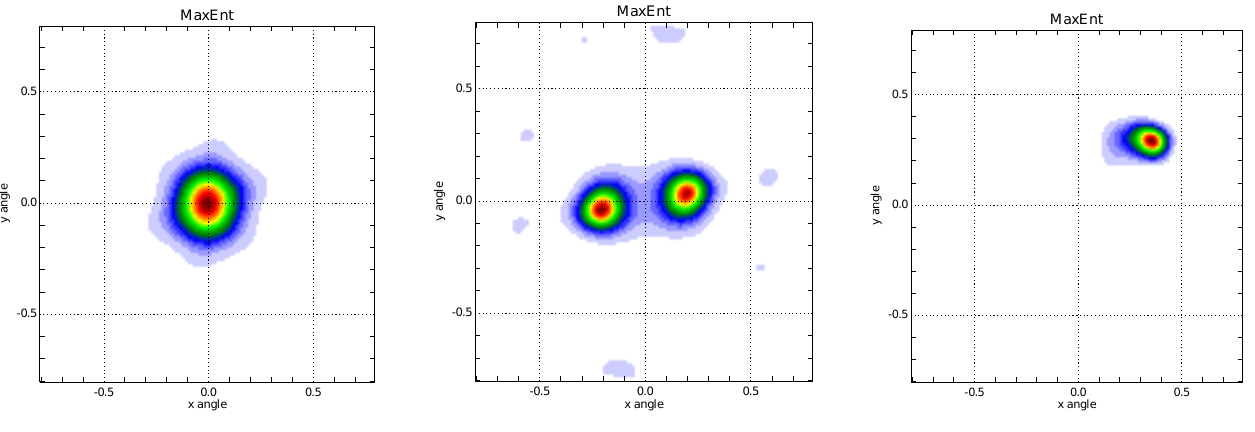
Fig. 7. Images of the model brightnesses of Fig. 1 obtained using the antenna configuration of Fig. 6 and the Maximum Entropy method. The slight tendency to elongate the features in the image seen in Fig. 5 is now gone.